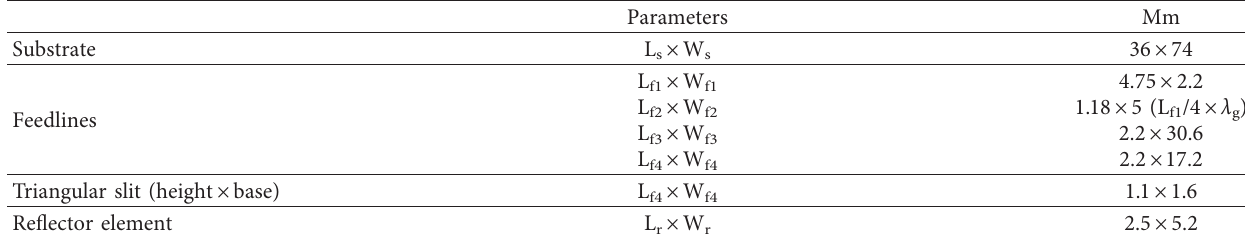
Table 3: Dimensions of the corporate-fed microstrip array